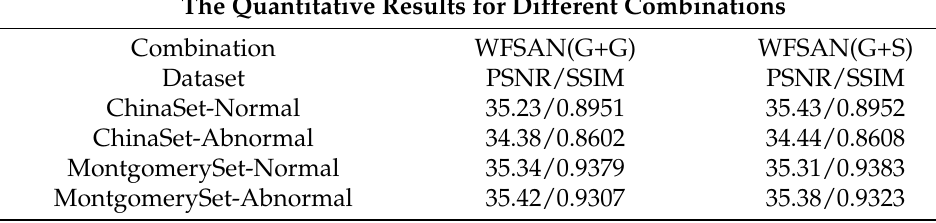
Table 4. Testing different